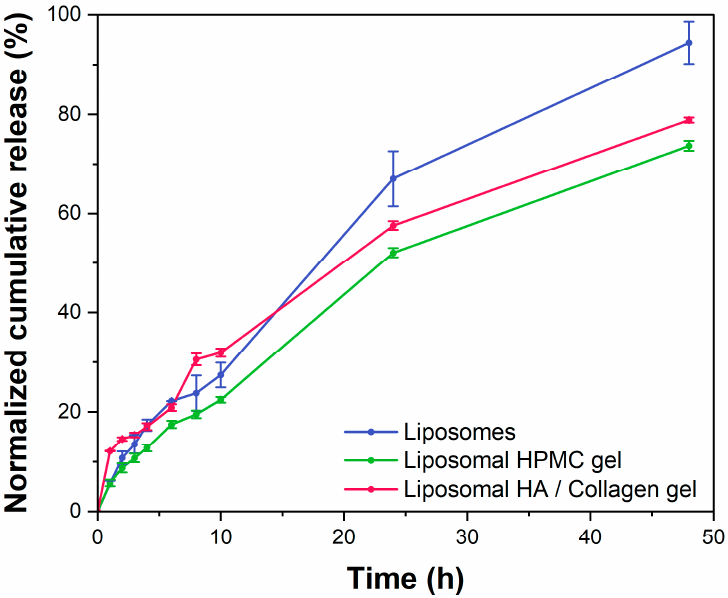
Figure 7. Comparative release study with the two nanostructured hydrogels and the liposomal dispersion (mean ± SD, n = 3).